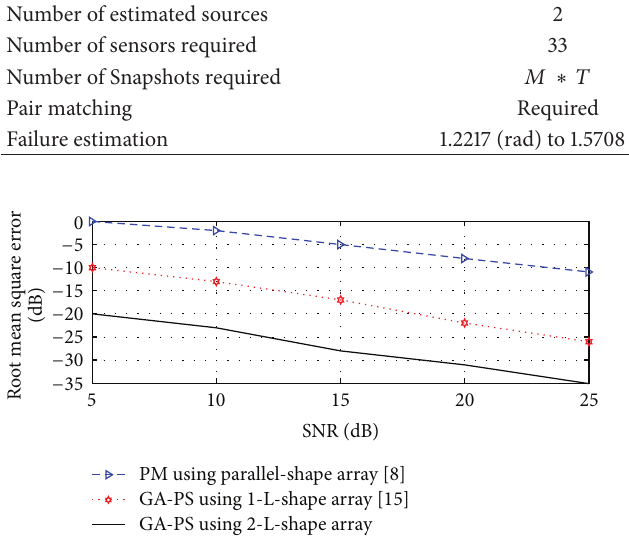
Figure 6: Root mean square error versus